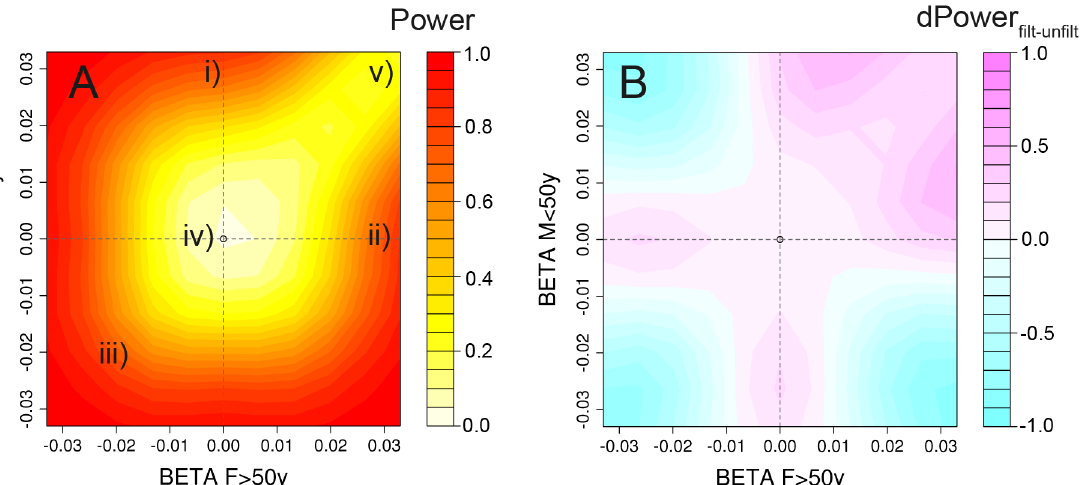
Fig 4. Power heatplots. Power for the combination of screens and gain through a priori filtering for varying configurations of effect sizes across the 4 strata. The figures illustrate (A) the power to detect age-difference, sex-difference or age-sex-difference in at least one of our scans (on P agediff , P sexdiff and P agesexdiff , with and without a priori filtering); and (B) a power comparison, comparing approaches with and without a priori filtering on P Overall < 1x10 -5 . We here assume four equally sized strata and a total sample size of N = 300,000 (comparable to the sample size in our BMI analyses). We set b F (cid:3) 50y = 0.033 (corresponding to a known and mean BMI effect in MAP2K5 region with R 2 = 0.037%), b M > 50y = 0, and vary b F > 50y and b M (cid:3) 50 on the axes. This strategy allows us to cover the most interesting and plausible interaction effects: Two-way interactions, such as (i) pure age-difference (b (cid:3) 50y = 0.033, b > 50y = 0) and (ii) pure sex-difference (b F = 0.033, b M = 0); and three-way interactions, such as (iii) extreme three-way interaction with opposite direction across AGE and SEX, (iv) 1-strata interaction (b F (cid:3) 50y = 0.033, b F > 50y = b M (cid:3) 50y = b M > 50y = 0), and (v) 3-strata interaction (b F (cid:3) 50y = b F > 50y = b M (cid:3) 50y = 0.033, b M > 50y =